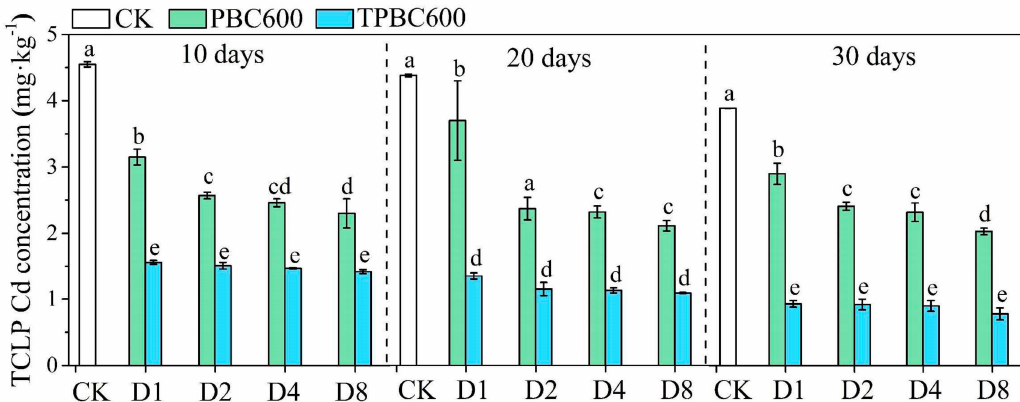
Figure 2. E ff ects of PBC600 and TPBC600 on cadmium availability in soil. Di ff erent letters indicate that